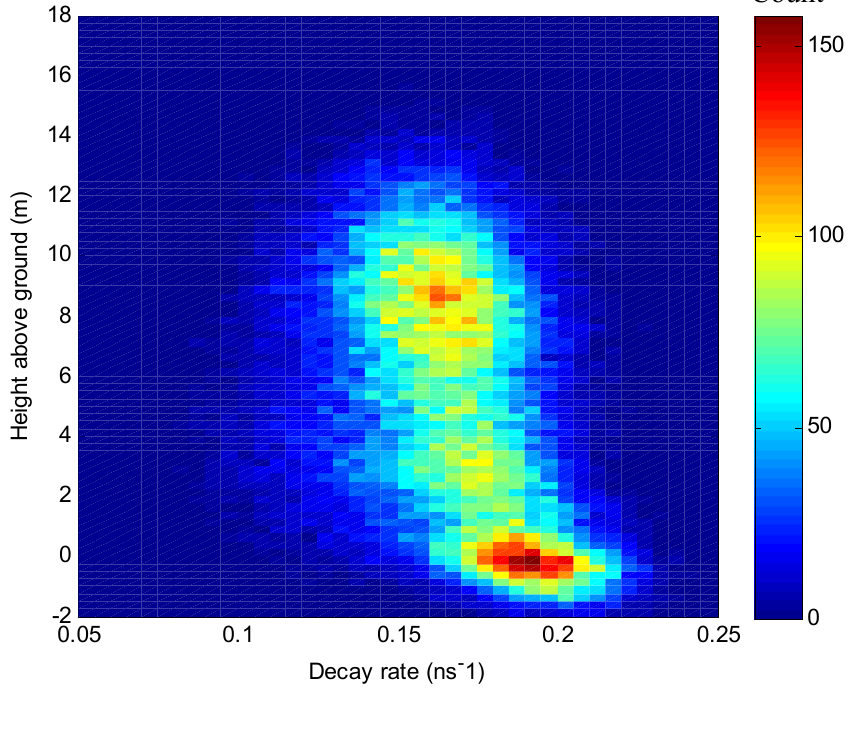
Figure 8. Bivariate frequency distribution of decay rate of exponential curves fitted to deconvolved waveform LiDAR vs . height above